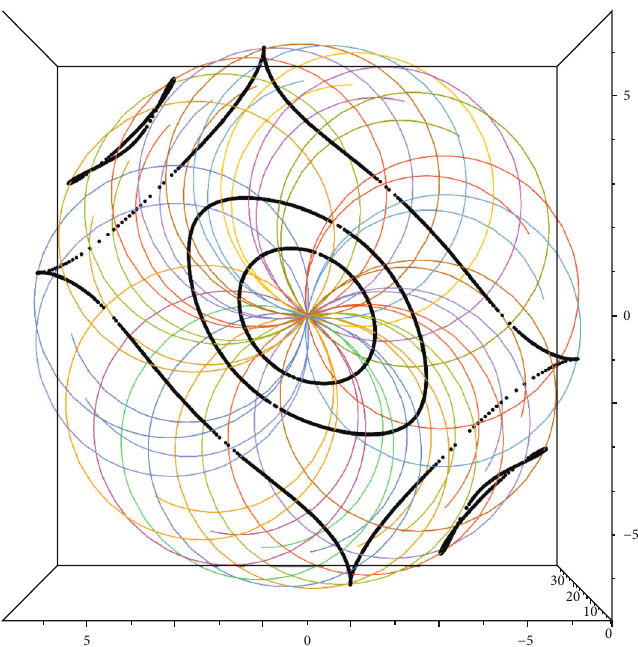
Figure 10: The same light cone and time cuts as in Figure 9 but viewed from a point above the light cone along the a ffi ne parameter axis. We see that the projection of these cuts is as shown in Figure 5. The projection of the outermost, disconnected portion is part of the wave front at t = 2 : 4 which causes a slight distortion in this fi gure away from the cusp shape seen in Figure